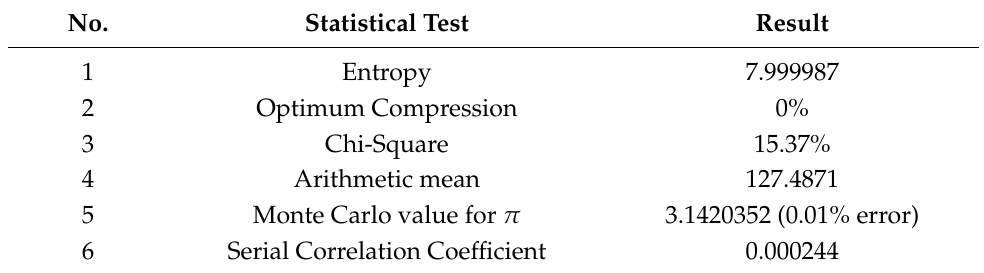
Table 4. ENT statistical test